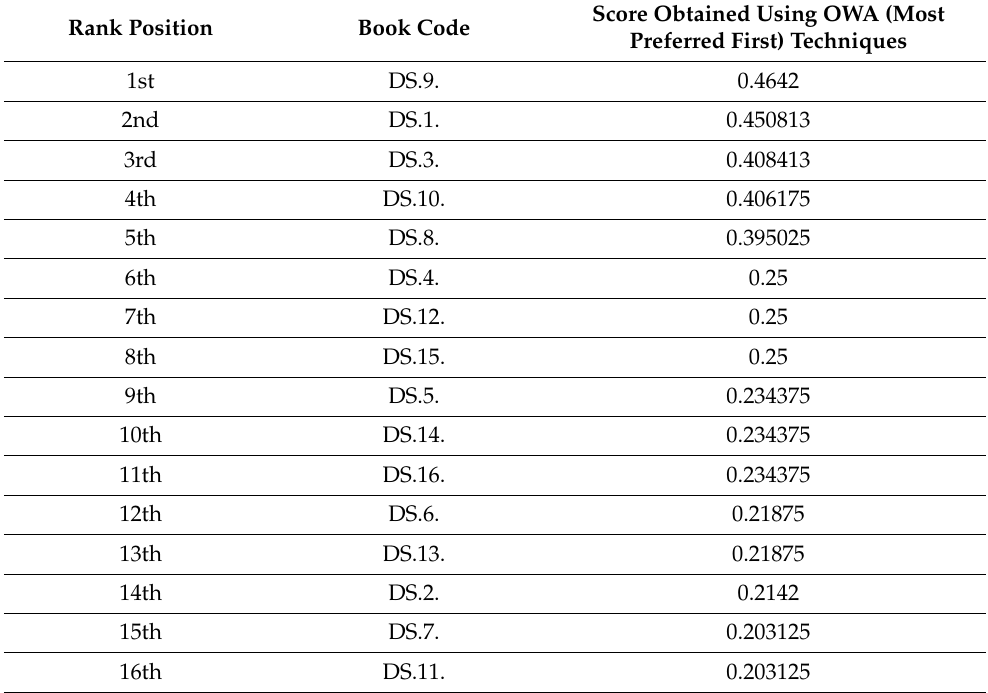
Score Obtained Using OWA (Most Preferred First) Techniques